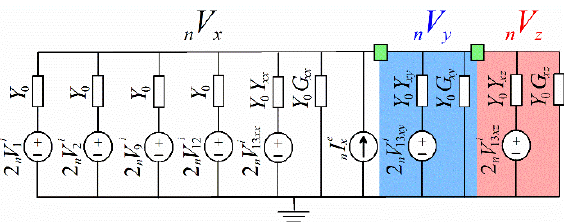
Figure 4. Thevenin equivalent circuit of the shunt node for E x at time t n . Green boxes denote a formal connection, allowing for the voltage at the upper terminals to be n V x for the link lines, the source, and lines 13 xx and 19 xx , while the voltage is n V y for lines 13 xy and 19 xy (in the pale blue region) and n V z for lines 13 xz and 19 xz (in the pale red region).